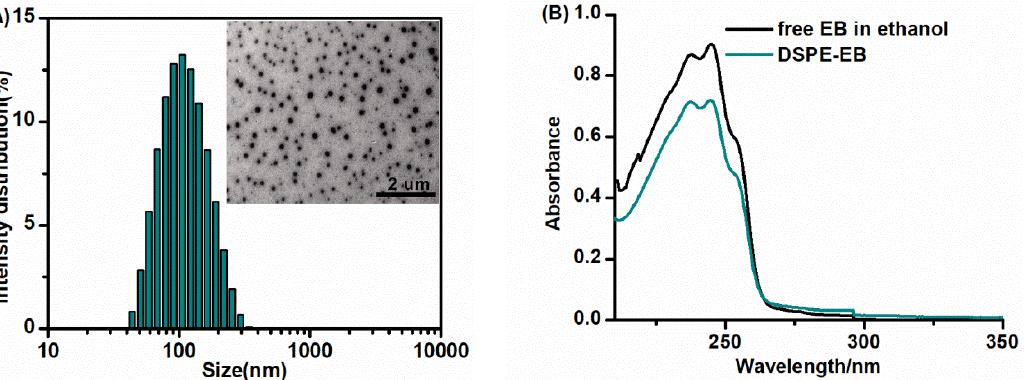
Figure 1. DLS size distribution and TEM images of DSPE-EB nanoparticles ( A ); the absorption spectra of DSPE-EB nanoparticles and free EB in ethanol ( B ).